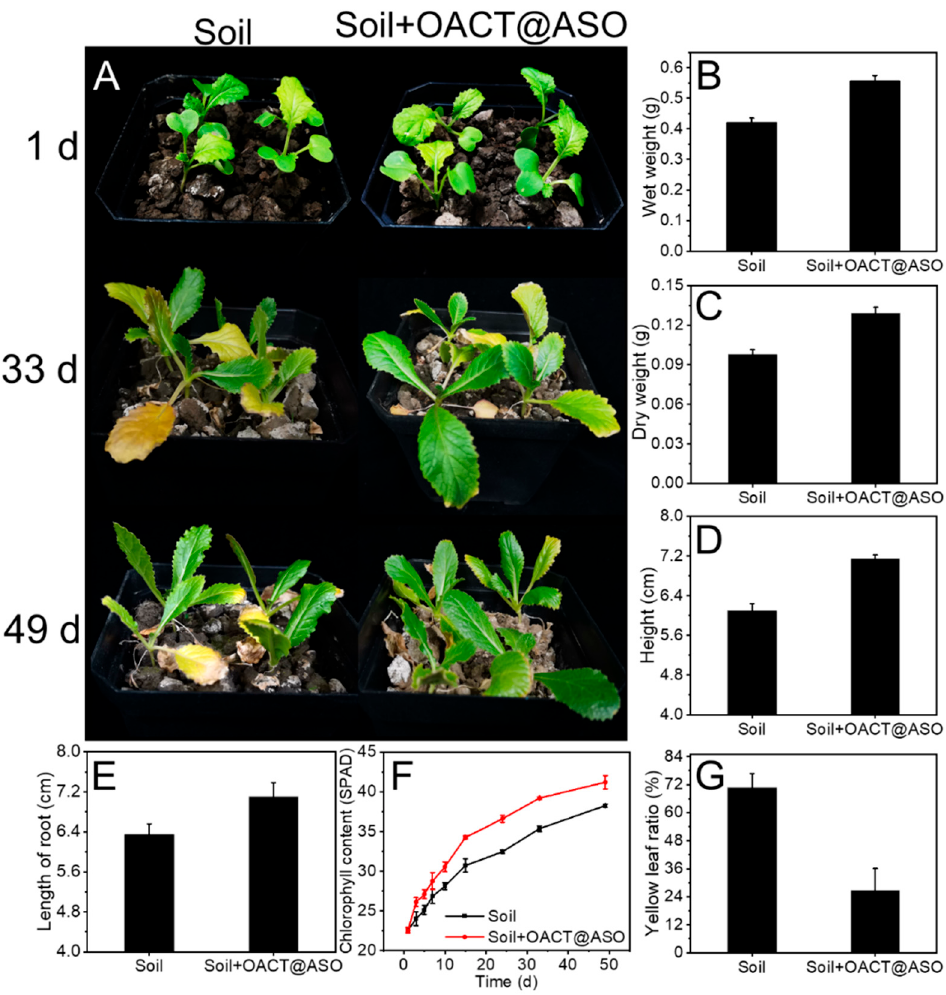
Figure 7. ( A ) Digital photographs of pakchoi seedlings in soil. ( B – G ) Wet weight, dry weight, height, length of root, chlorophyll content, and yellow leaf ratio of pakchoi seedlings.